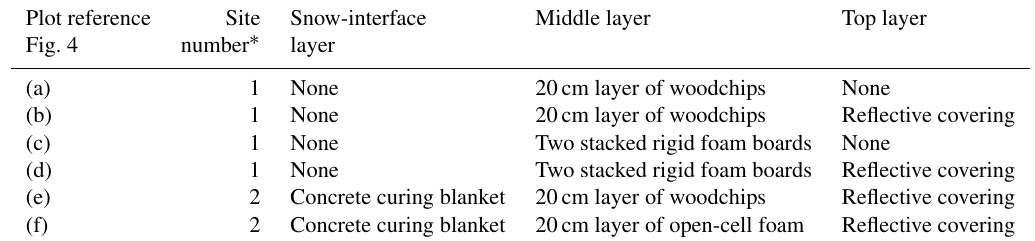
Table 2. Properties of the 2018 covering experiments. Plot reference